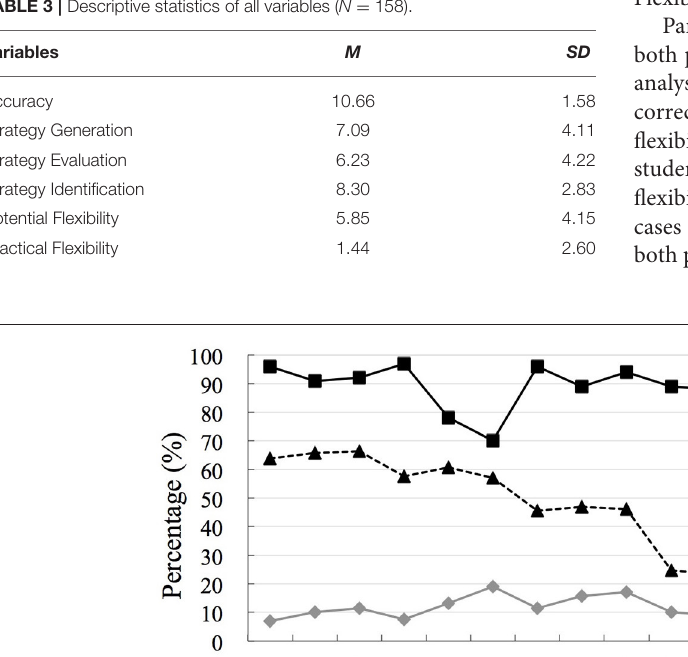
Frontiers in Psychology |